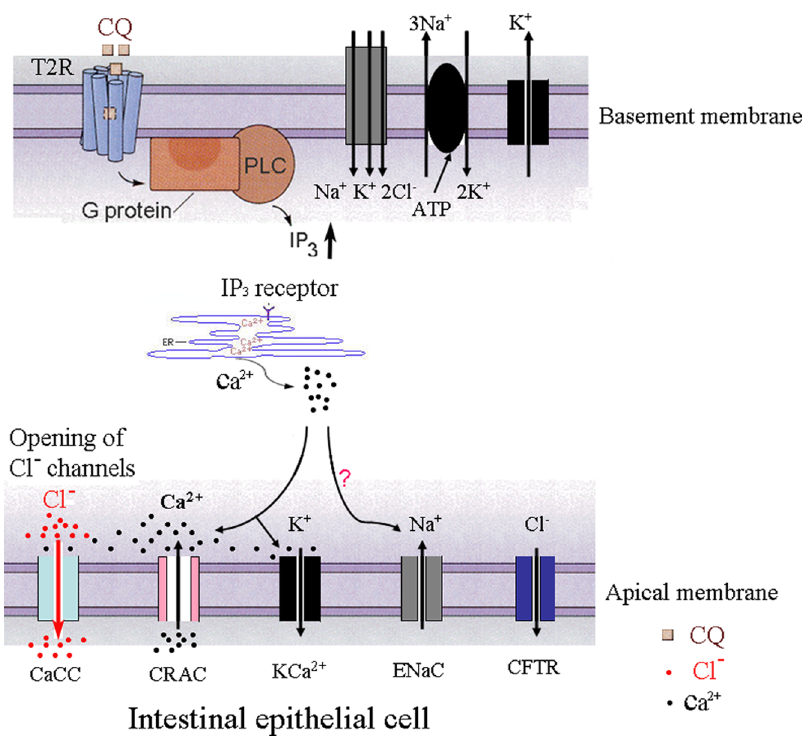
Figure 6. A working model of CQ in intestinal epithelial cells. CQ binds to T2Rs activating a G-protein to produce phospholipase C (PLC) in the basement membrane of intestinal epithelial cells followed by Ca 2 + release from the sarcoplasmic reticulum (SR). Local Ca 2 + entry through store- operated Ca 2 + release-activated Ca 2 + channels(CRAC) drives Cl 2 secretion by stimulating Ca 2 + -activated Cl 2 channels(CaCC) in the apical membrane of intestinal epithelial cells. The intracellular-free chloride concentration is maintained by a Na + -K + -2Cl 2 co-transporter that actively accumulates Cl 2 .